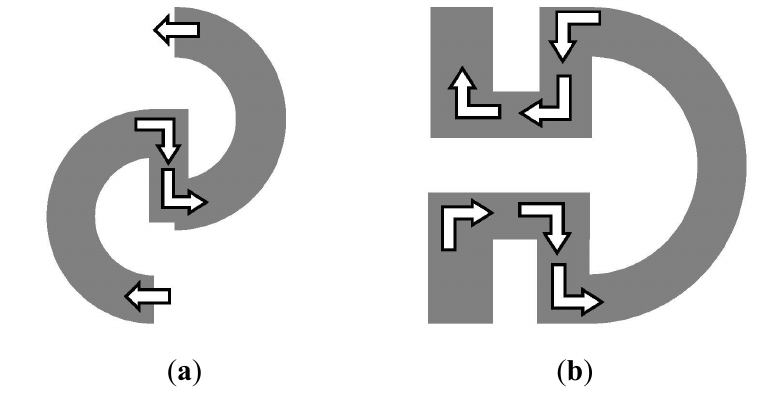
Figure 5. Rapid flow reversal in ( a ) ILSC mixing module and ( b ) rapid flow deflection in the Ω mixing